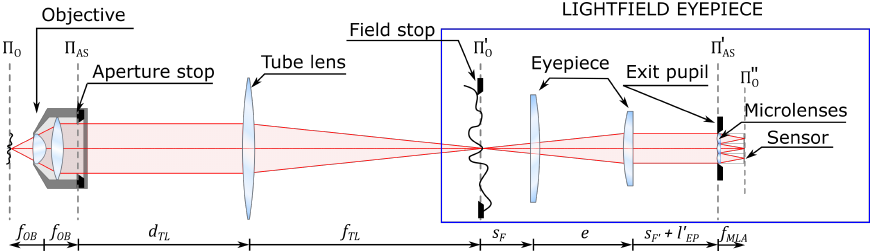
Figure 1. Optical scheme of the Fourier integral microscope with the lightfield microscope eyepiece highlighted in blue. Π 0 is the object plane, f OB is the focal length of the microscope objective, Π AS is the plane of the aperture stop of the microscope objective. d TL is the distance from the aperture stop plane to the tube lens, f TL is the focal length of the tube lens. Π ’ 0 is the conjugate of Π 0 , namely the intermediate image plane. s F is the distance from the front focal plane of the eypiece to the first lens of the eyepiece, e is the distance between the lenses of the eyepiece, s F’ is the distance from the second lens of the eyepiece to the back focal plane of the eyepiece. Π ’ AS is the conjugate of Π AS , namely the exit pupil plane, l (cid:48) EP is the distance from the back focal plane of the eyepiece to the exit pupil plane, f MLA is the focal length of the microlenses. Π ” 0 is the conjugate of Π ’ 0 , namely the image